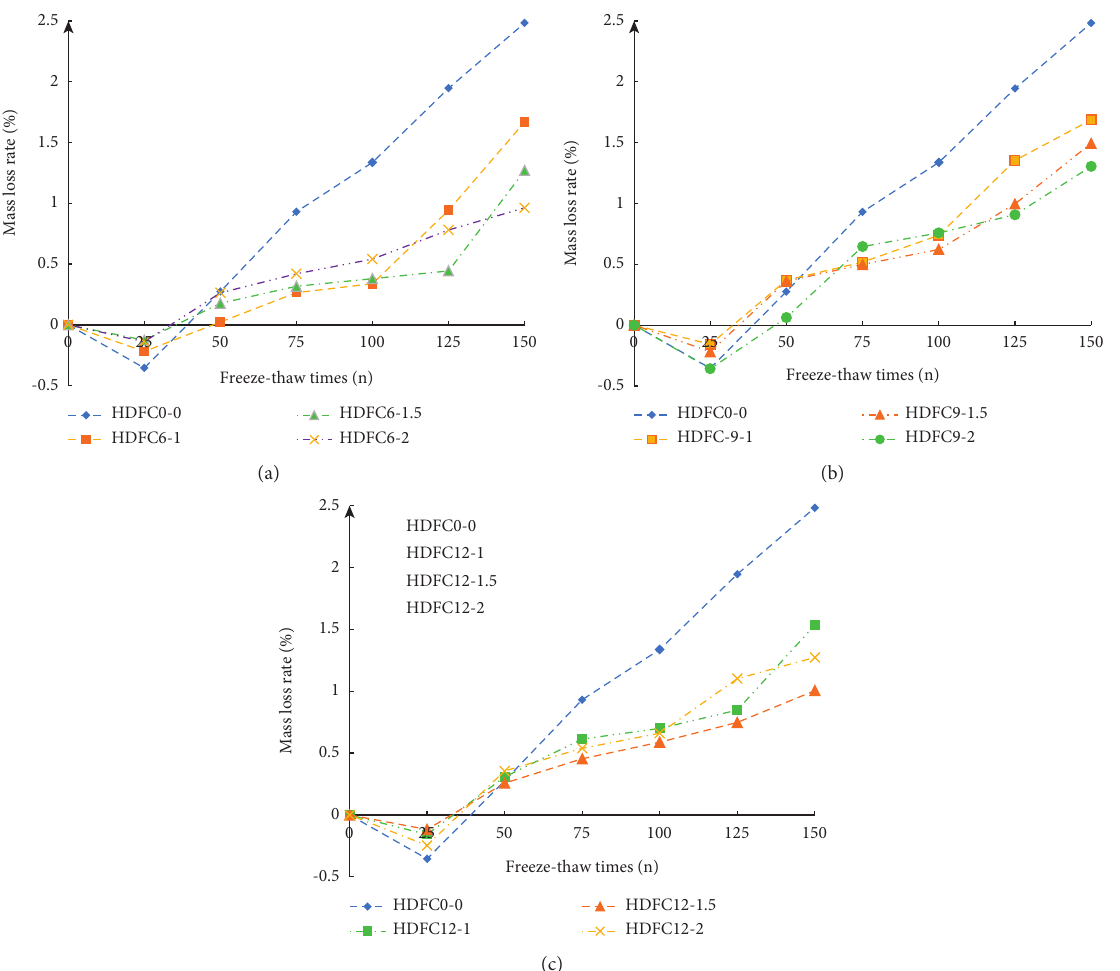
Figure 3: The relationship between mass loss rate and number of freeze-thaw cycles: (a) HDFC6-1-HDFC6-2. (b) HDFC9-1-HDFC9-2. (c)